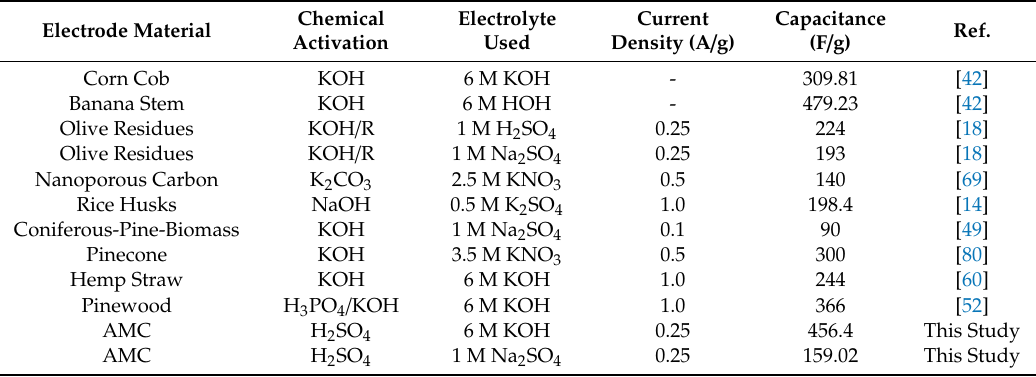
Table 2. Performance of supercapacitors with di ff erent electrode materials from di ff erent biomass sources chemically treated with di ff erent impregnation from literature in comparison with this current study.